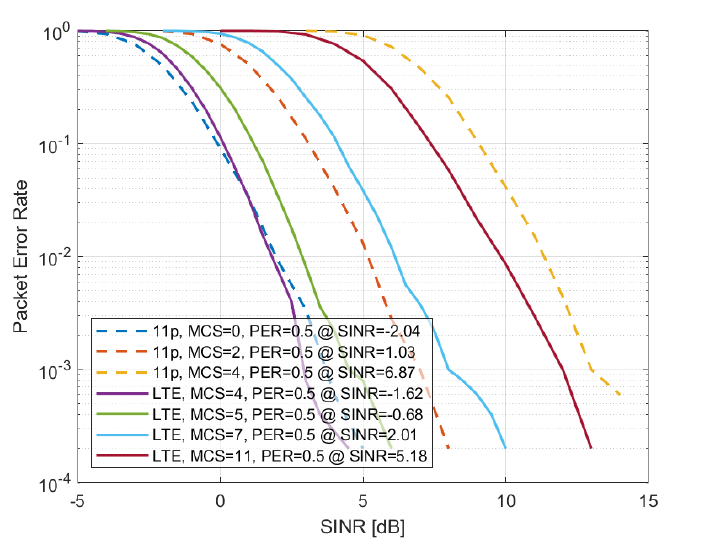
Figure 4. PER vs. SINR curves for IEEE 802.11p and LTE-V2X as a function of SINR in the highway LOS scenario for some of the possible MCSs and assuming packets of 350